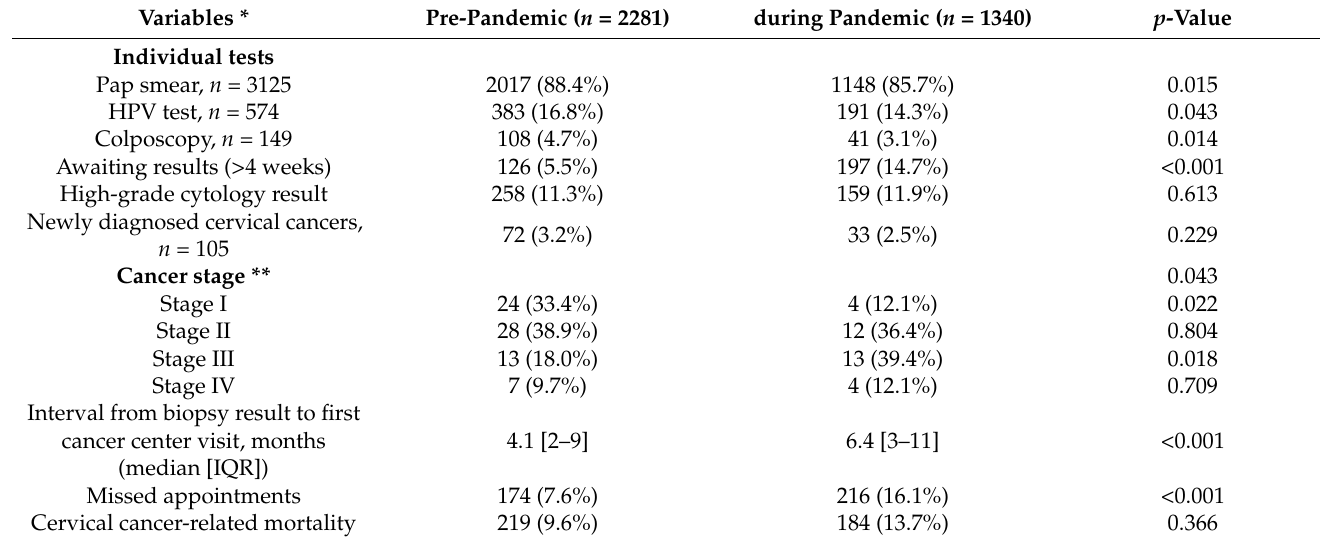
Table 2. Medical investigations characteristics of patients presenting in the outpatient setting for cervical cancer investigations and treatment before and during the COVID-19